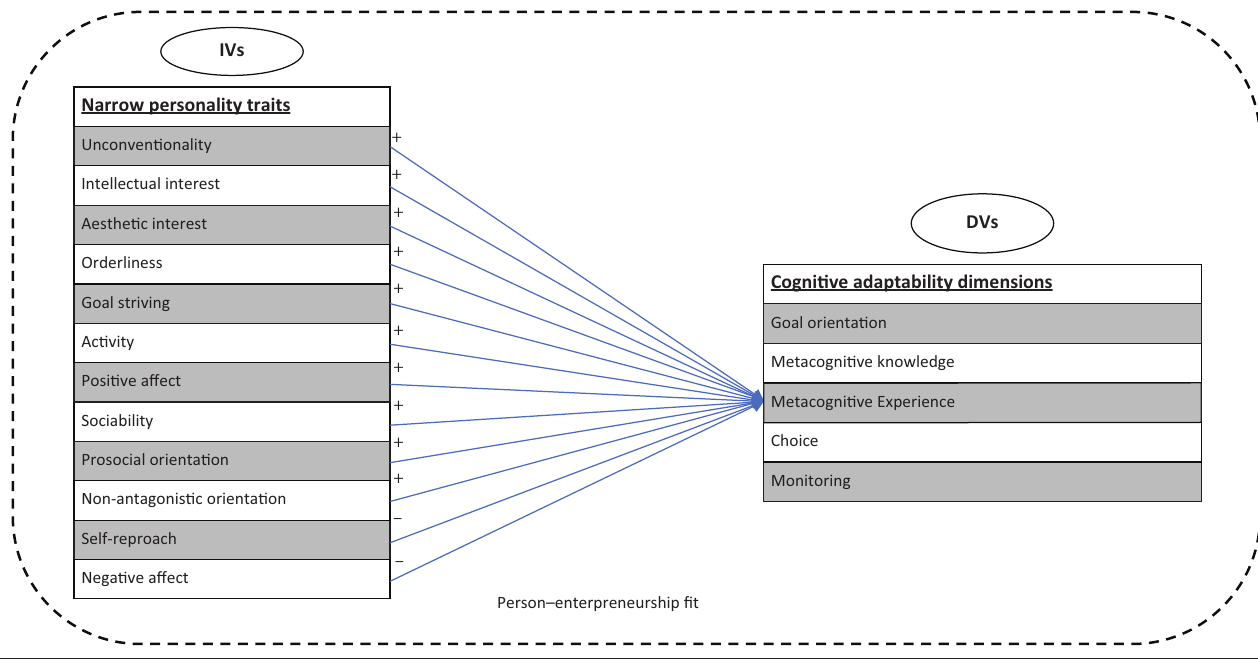
FIGURE 1: Proposing a model of person–entrepreneurship fit for established